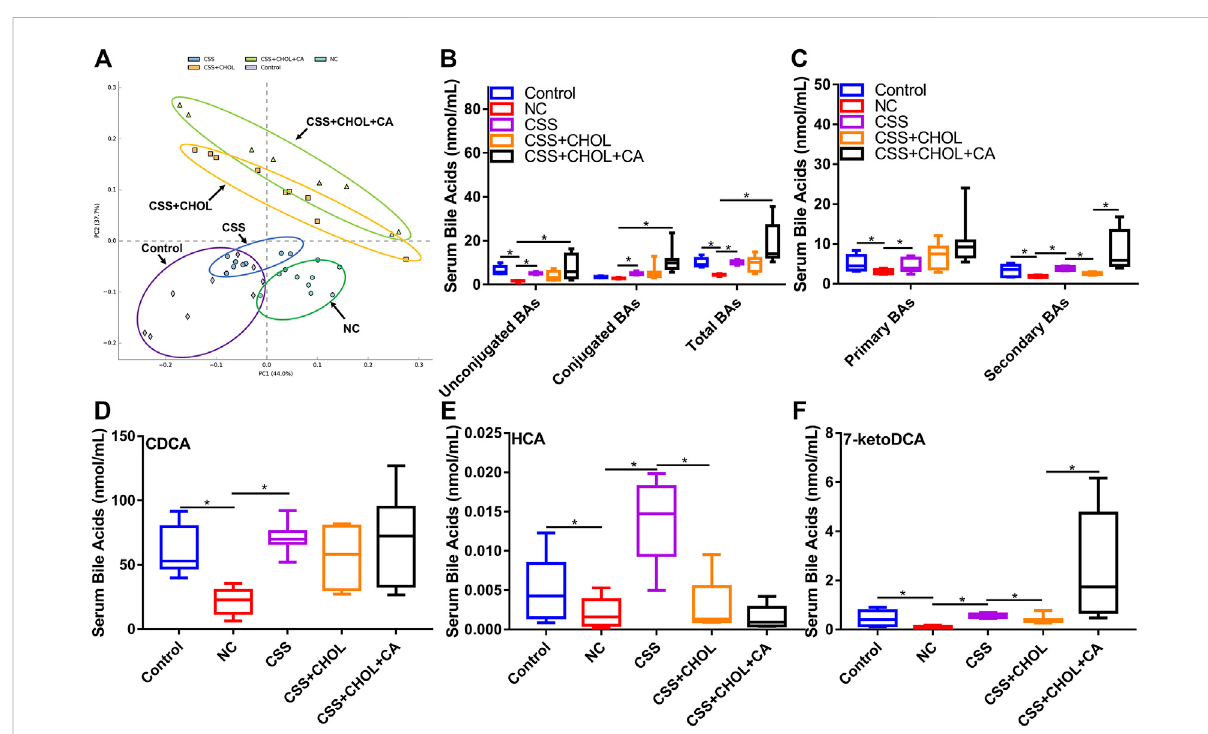
FIGURE 2 CSS restores serum BA levels in CUMS mice using a mechanism dependent on intestinal reabsorption. MS was used to pro fi le levels of 42 distinct BAs inserum from control mice as well as mice exposed to CUMS and treatedwith saline (NC), CSS, or CSSalong with theBA sequestrant CHOL (with or without CA supplementation). (A) PCA plot highlighting different groups based on serum BA concentrations. (B) Concentration of unconjugated, conjugated, and total BAs in serum collected from different groups. (C) Concentration of primary and secondary BAs in